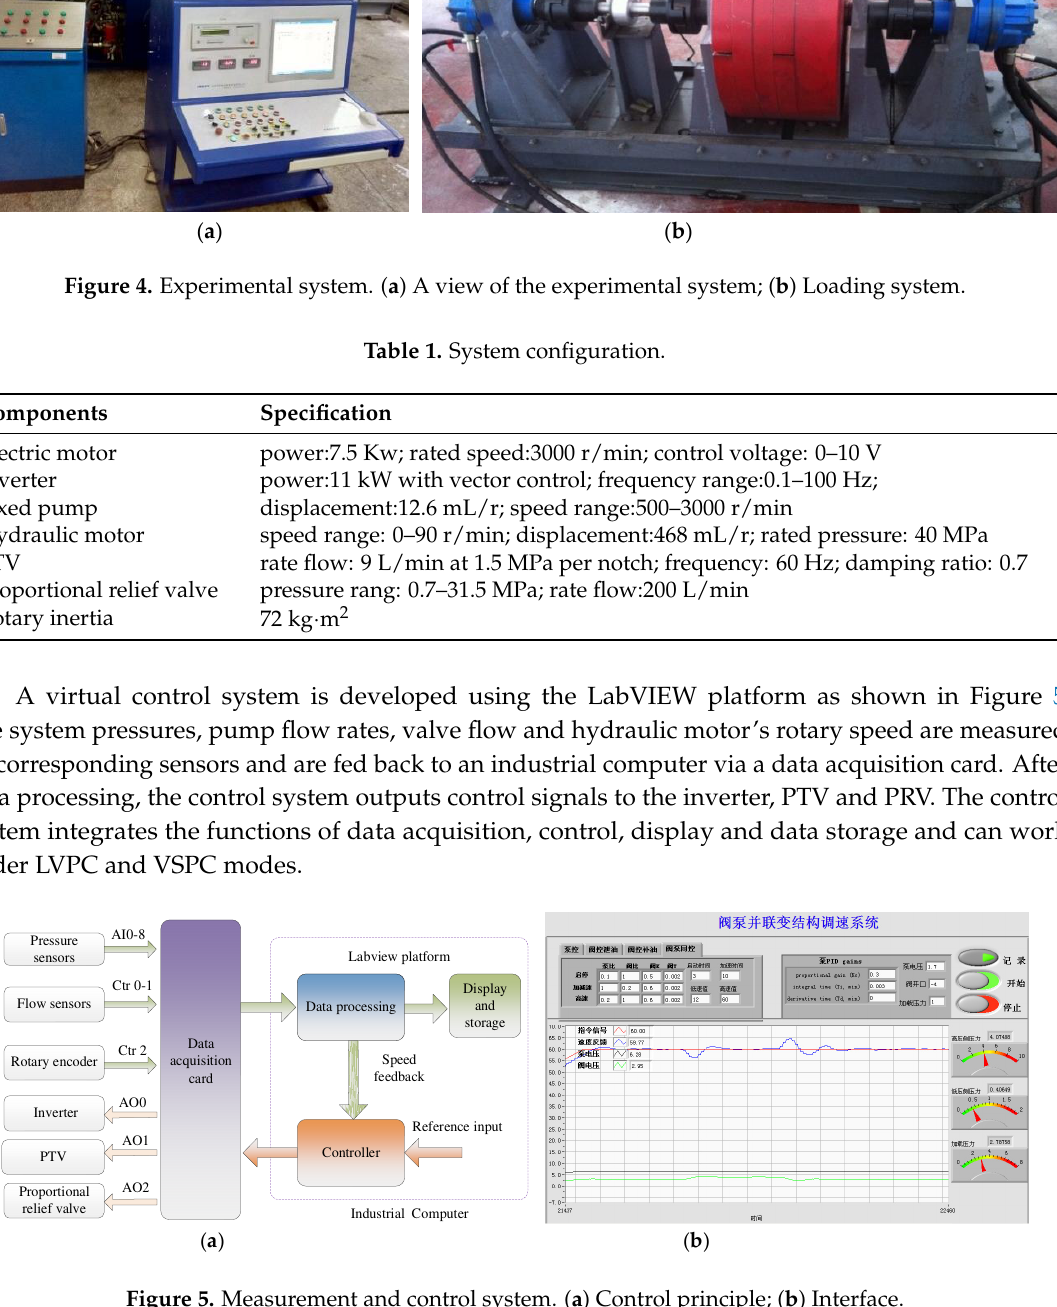
Figure 5. Measurement and control system. ( a ) Control principle; ( b ) Interface.